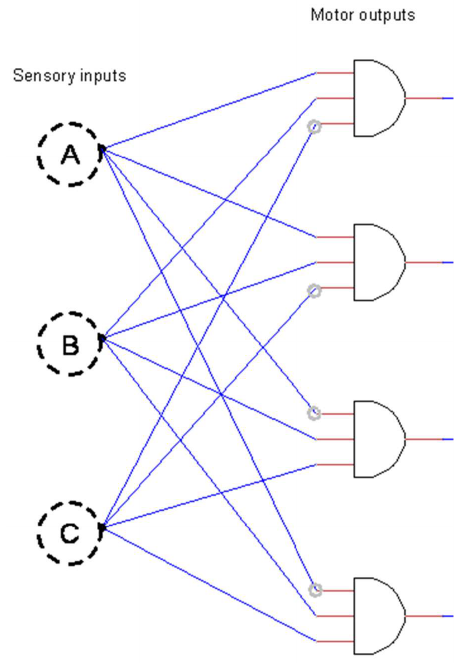
Figure 2. Diagram of a neural circuit with three sensory inputs and four logic gates that correspond to the four motor outputs and shows a solution for the AND/NOT case (Table 1). The small gray circles between red and blue lines represent a potential inversion of the input signal, a NOT operation. The sensory inputs are labeled A to C.